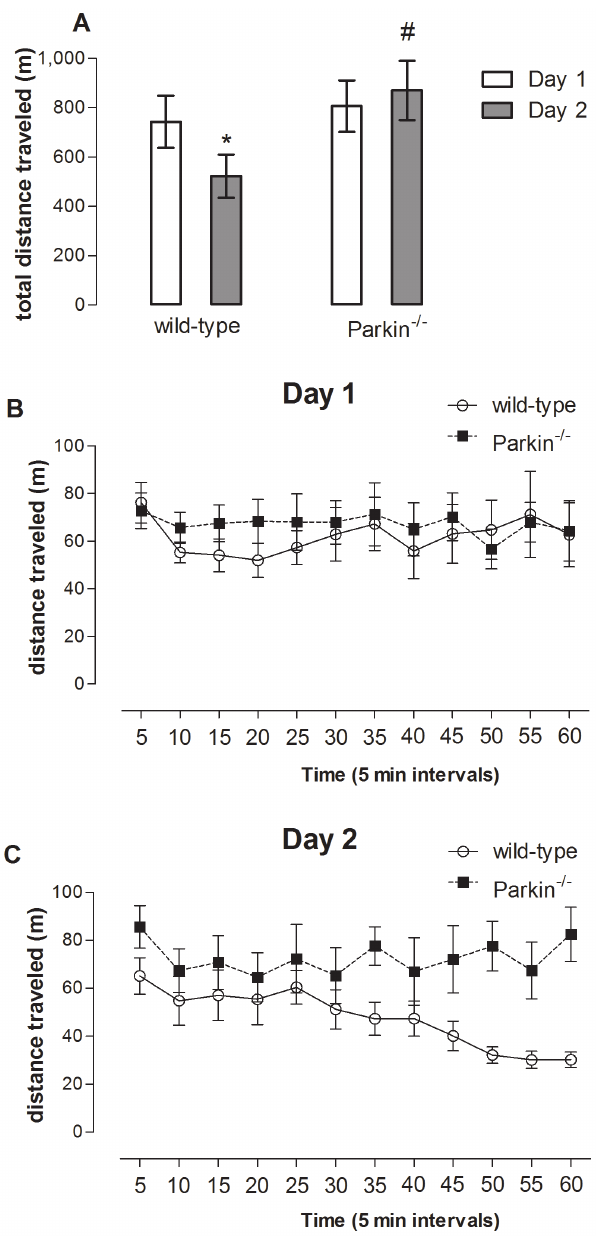
Figure 1. Effects of parkin genetic deletion on locomotor activity and habituation. (A) total distance traveled by wild-type and parkin 2 / 2 mice at days 1 and 2 of analysis in an open field arena. *P , 0.05 compared to day 1, # P , 0.05 compared to day 2 of wild-type group using a Newman-Keuls post-hoc test. (B) Pattern of locomotion at day 1 (divided in blocks of 5 min) of wild-type and parkin 2 / 2 mice. (C) Pattern of locomotion at day 2 (divided in blocks of 5 min) of wild-type and parkin 2 / 2 mice. Data are mean ¡ s.e.m. of n 5 9–10 per group.